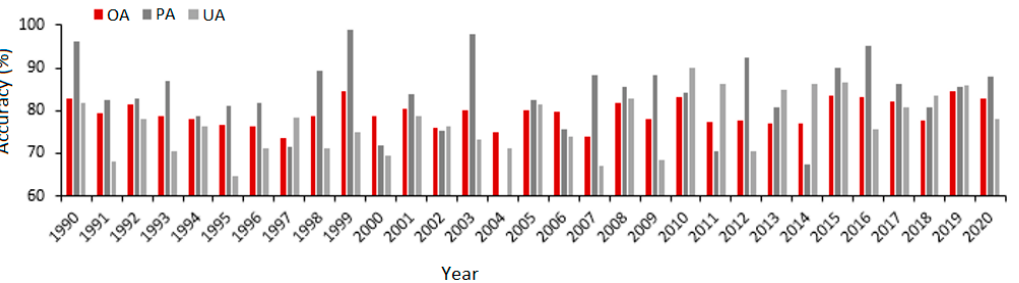
Figure 5. Accuracy of the hard classi fi cations performed with Landsat scenes between 1990 and 2020. OA—overall accuracy; PA—producer’s accuracy; UA—user’s accuracy.